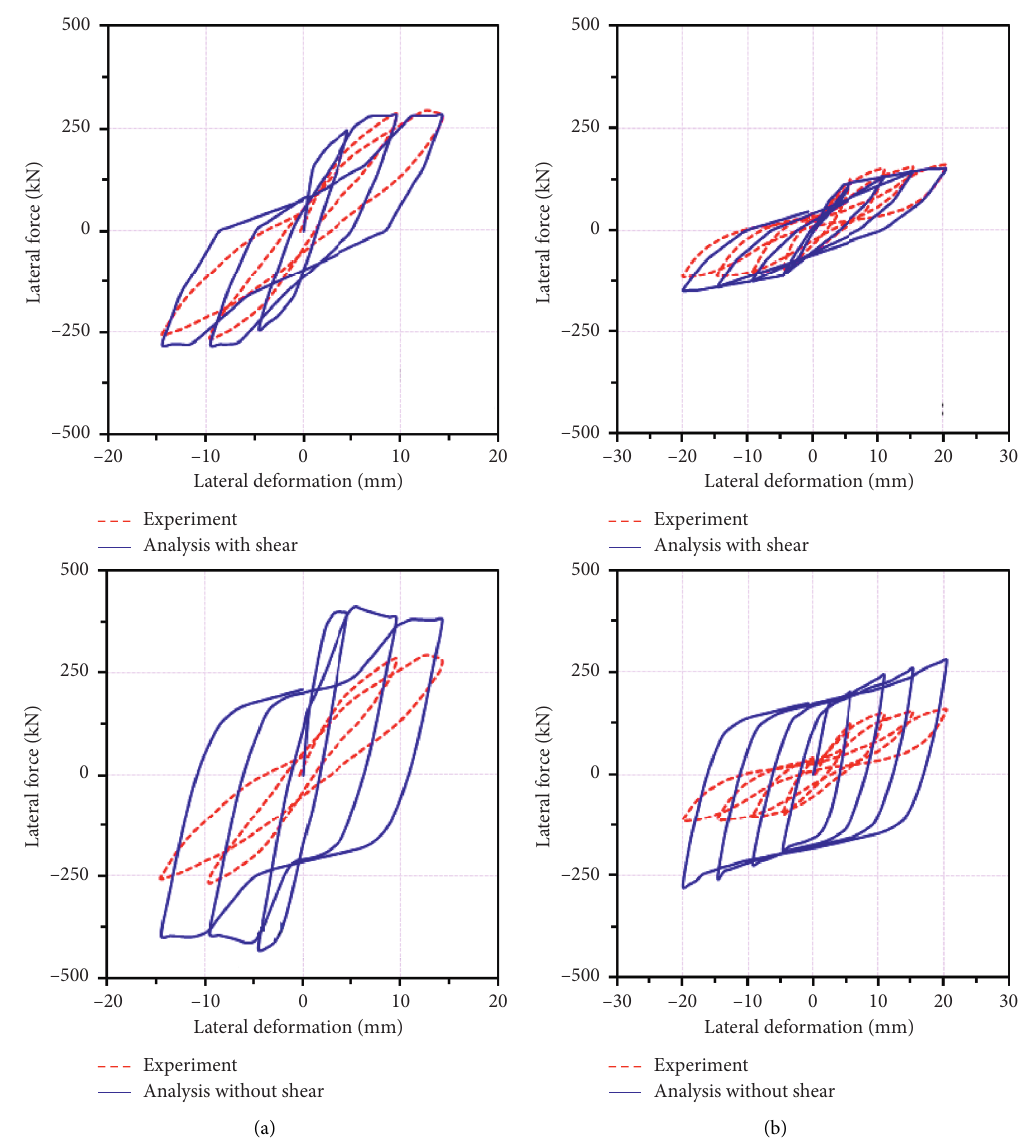
Figure 2: Representative validation of hysteretic shear representation [39]. (a) Specimen 120C-U. (b) Specimen